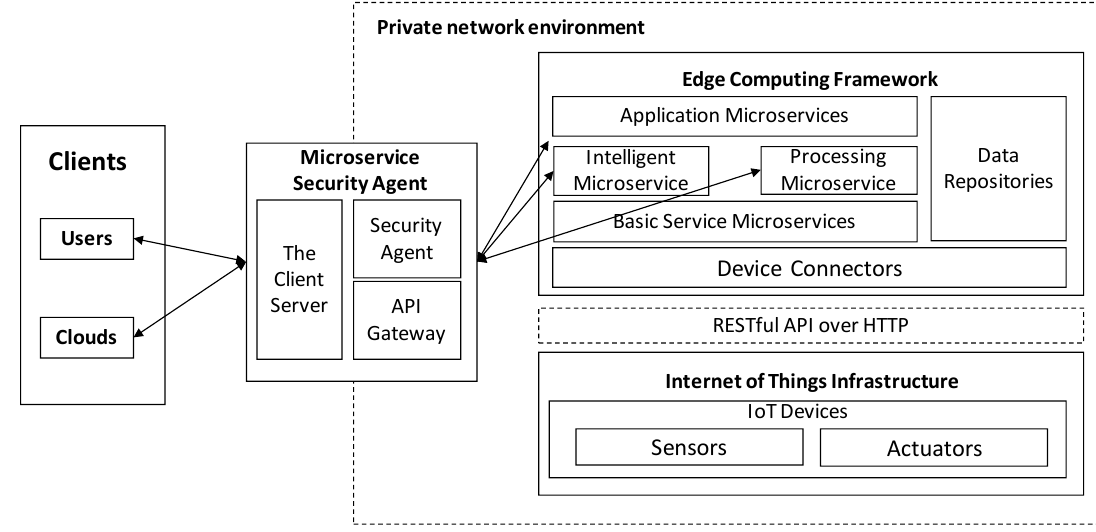
Figure 1. Edge Computing Environment